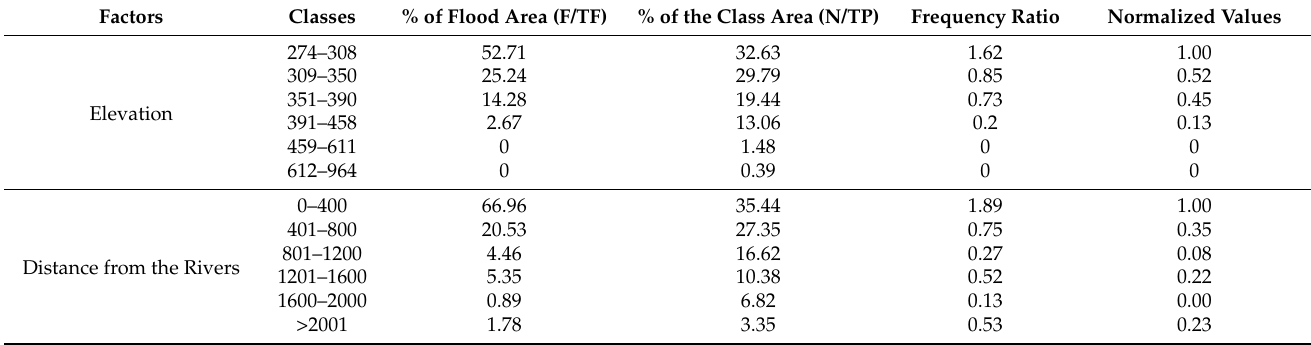
Figure 7. Distance from rivers map of the study area. Table 3. Relation between flood locations and its conditioning factors using the FR method.